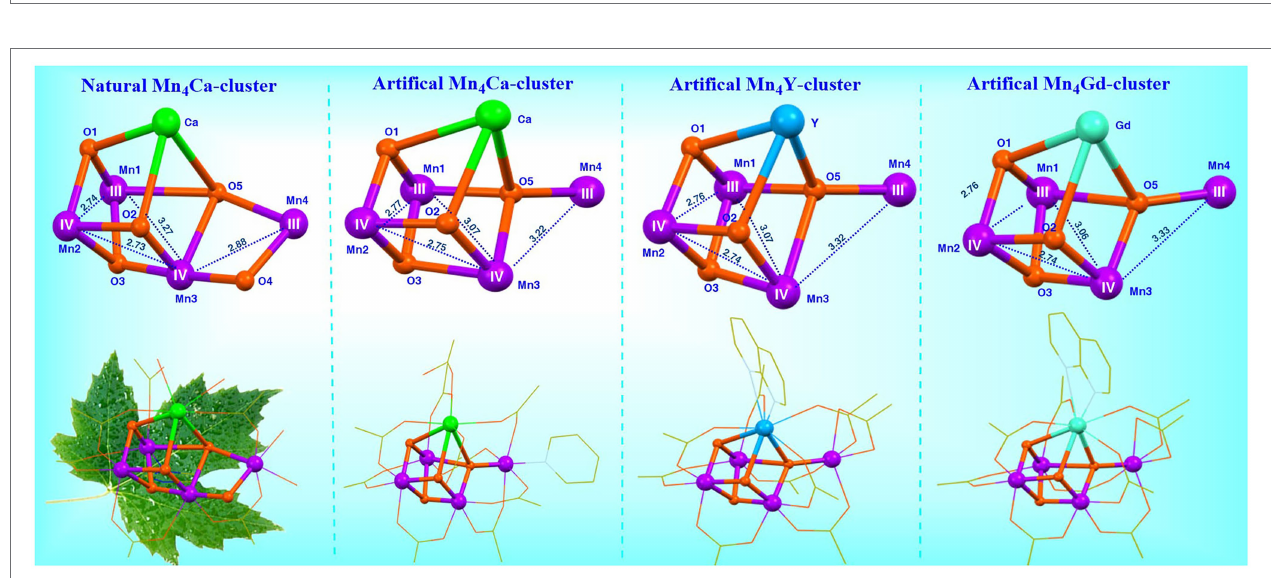
FIGURE 9 | Structural comparison of three artificial Mn 4 CaO 4 -complexes ( 4 , 8 , 9 ) (Zhang et al., 2015; Chen et al., 2019). (A) Core of 4 ; (B) structure of 4 ; (C) core of 8 ; (D) structure of 8 ; (E) core of 9 ; (F) structure of 9 . All illustrations are the same as those in Figure 5 .